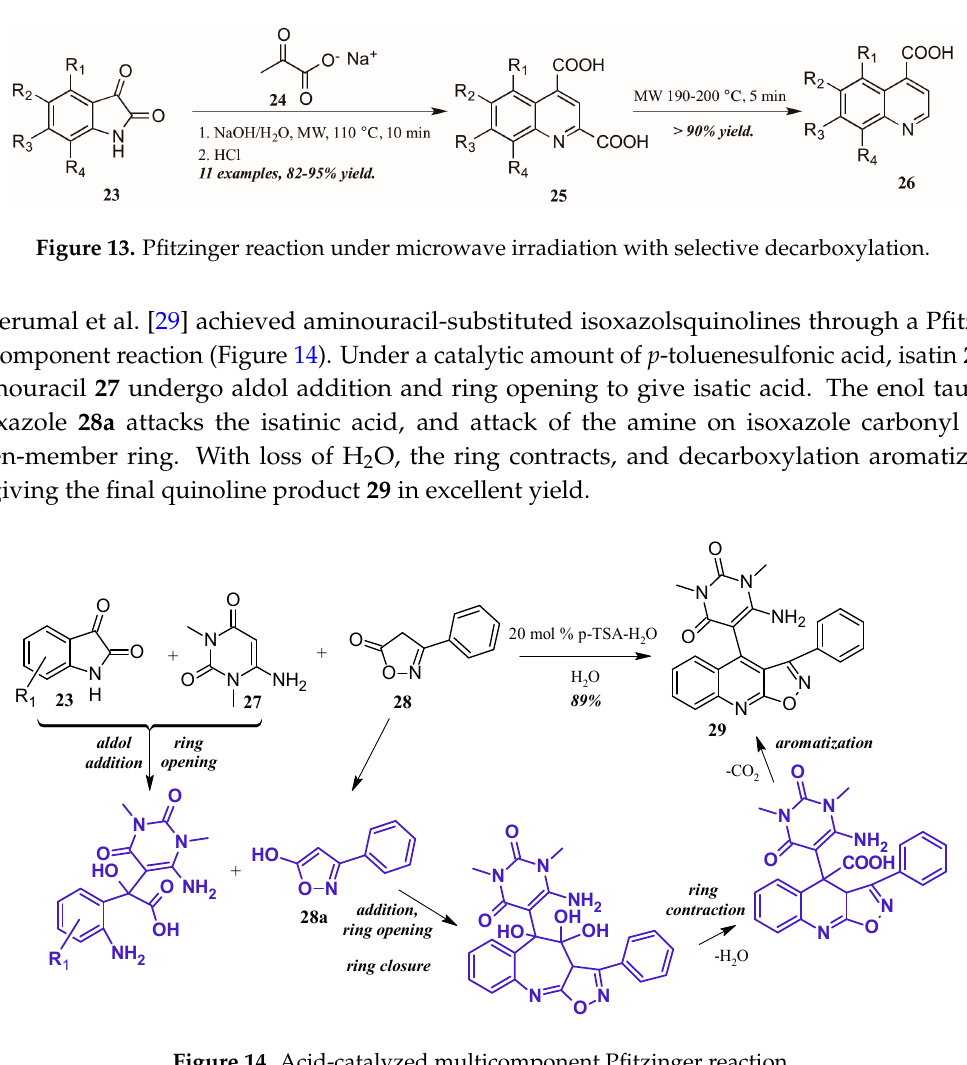
Figure 14. Acid-catalyzed multicomponent Pfitzinger reaction.